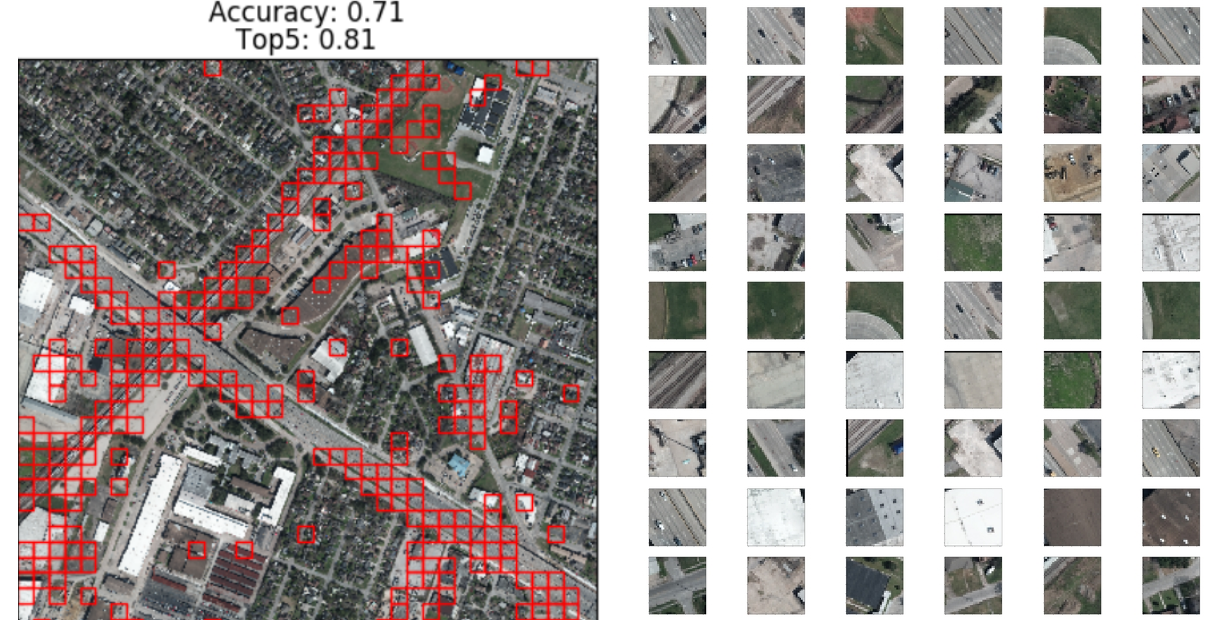
Figure 8. Target RGB patches (left column) and the wrong Top-5 retrievals (following